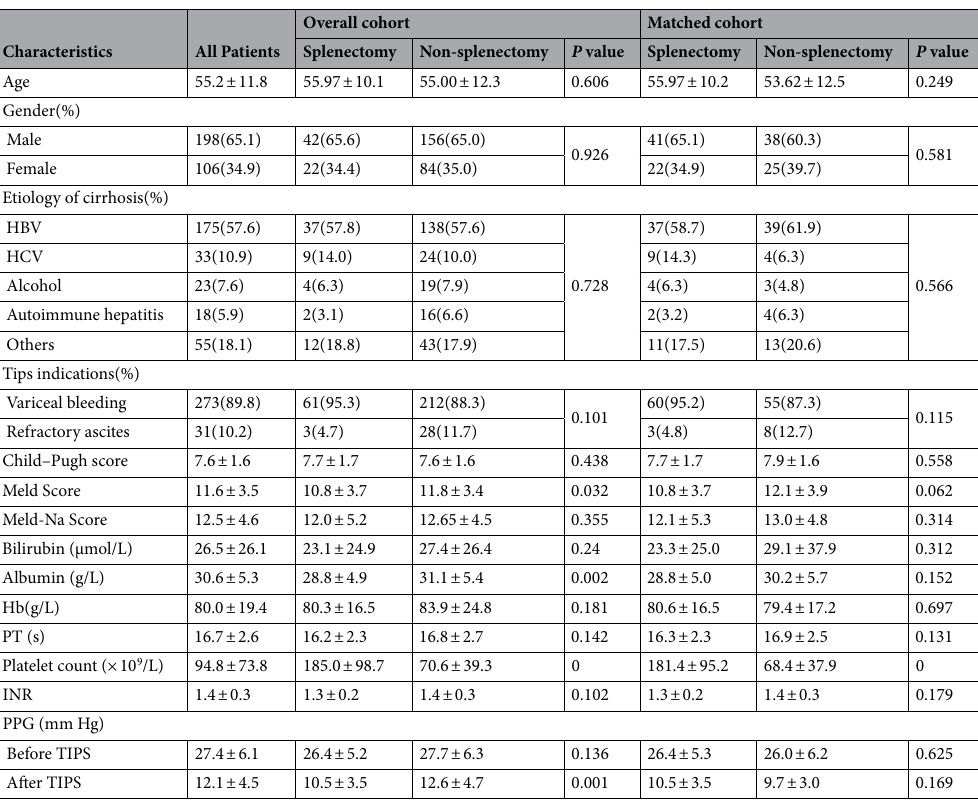
Table 1. Select baseline